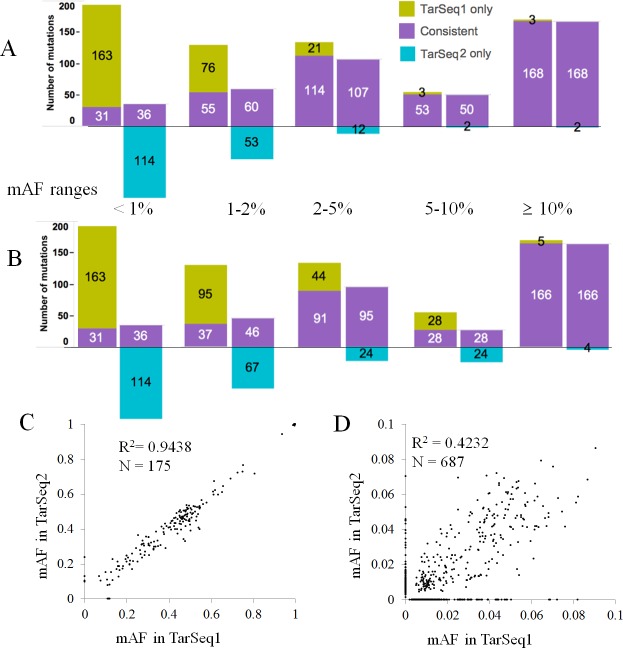
Dependence of consistency in mutation calls on cutoff level of mAF for repeated targeted sequencings.A. Consistency between first (TarSeq1) and second (TarSeq2) targeted sequencings for indicated mAF ranges {< 1%, 1% ≤ and < 2% (1–2%), 2% ≤ and < 5% (2–5%), 5% ≤ and < 10% (5–10%), and ≥ 10%}, when all mutation calls with any mAFs in either TarSeq1 or TarSeq2 are considered as true mutations. B. Consistency between two targeted sequencings, when mutation calls with mAF value ≥ 10% for both TarSeq1 and TarSeq2 are considered as true mutations. For both A and B, consistent calls between the two results are marked in purple, calls only from TarSeq1 (TarSeq1 only) in light green, and calls only from TarSeq2 (TarSeq2 only) in light blue; the left and right paired columns for each AF range are the data from TarSeq1 and TarSeq2, respectively; X-axis, mutant AF ranges; and Y-axis, number of mutation calls. C. Comparison of mutant AFs between two targeted sequencings results such as for hmAF mutation calls showing mAF ≥ 10% (R = 0.9438). D. Comparison of mAFs for calls showing mAF < 10% between two targeted sequencings (R = 0.4232). For C and D, X-axis is for TarSeq1 and Y-axis is for TarSeq2.